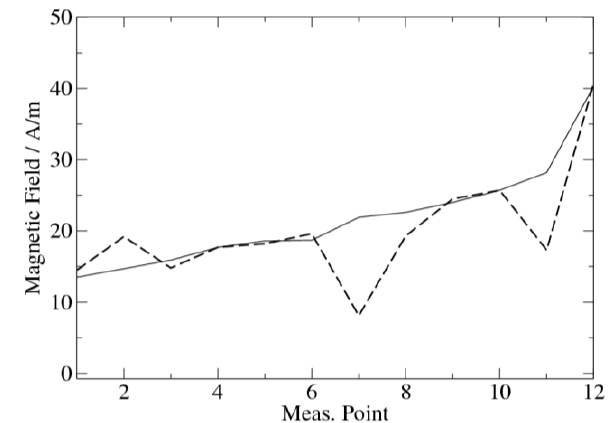
Figure 3. Comparison between measurements and simulations of magnetic fields inside a wind turbine hub due to injected current [5]. The solid line represents simulation results with FEKO while the dashed line connects the measured field values at discrete measurement points inside the hub.